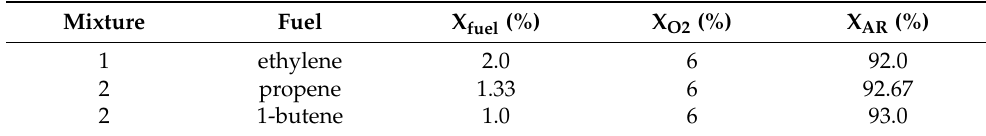
Table 1. Composition of the fuel mixtures tested in this study.